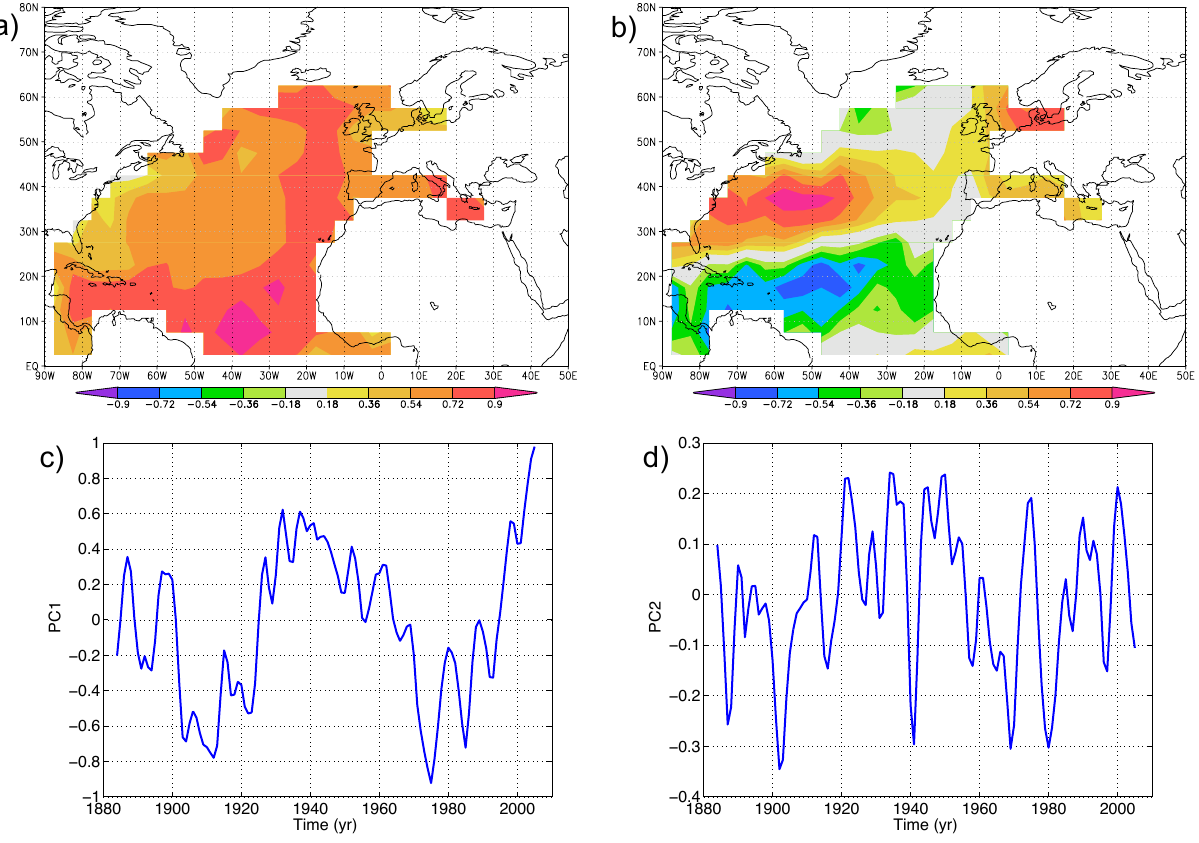
Fig. 8. North Atlantic EOFs using the updated GISST sea surface temperature data set (Rayner et al., 2006). (a) First EOF: 38% of the variance, (b) EOF2: 9% of the variance. (c) Principle component PC1, (d) PC2. The data were detrended, and a 5-yr low-pass filter was applied (see